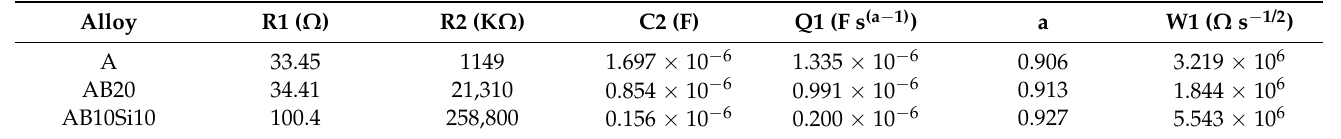
Table 2. Parameters from the fitting of the Nyquist plot to an equivalent electrical